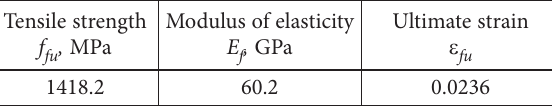
Table 2. Mechanical properties of GFRP rebars